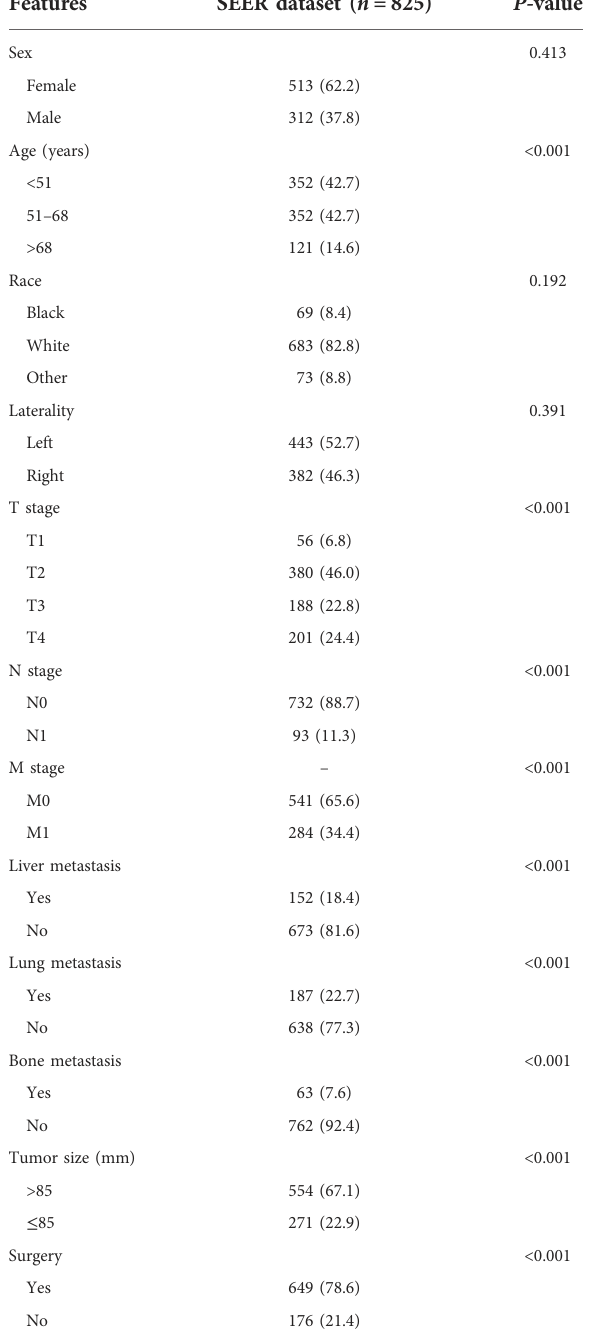
TABLE 2 Description of the study population deriving from the SEER program database.